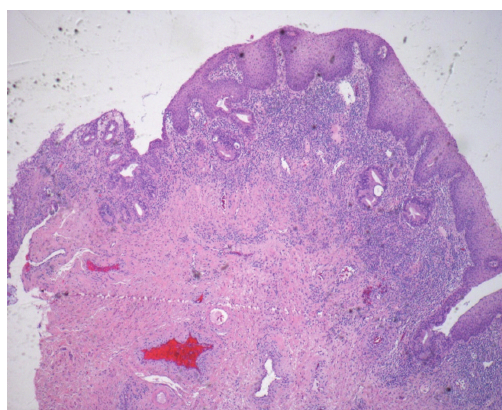
Figure 2: Rectal biopsy showing mucosal and submucosal atypical hematopoietic cell infiltration.